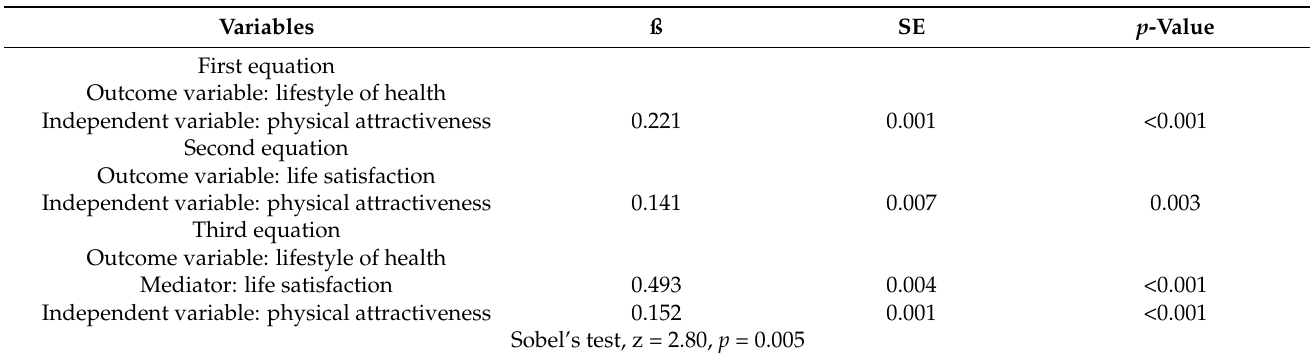
Table 4. Hypothesis testing for a mediating effect of life satisfaction on the association between physical attractiveness and lifestyle of